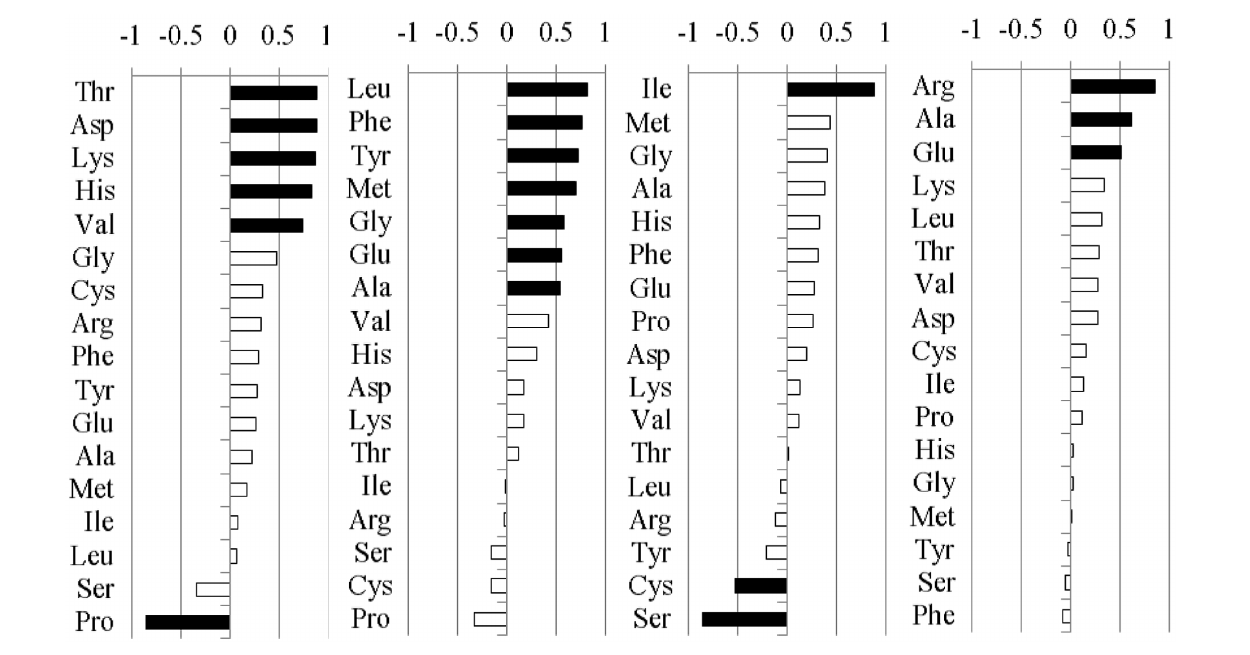
FIGURE 2 | Loadings for each individual amino acid of EI or EF A. sibiricum onto the first four rotated factors (RFs). The individual amino acids loading heavily either positively (loading ≥ + 0.5) or negatively (loading ≤ − 0.5) are highlighted in